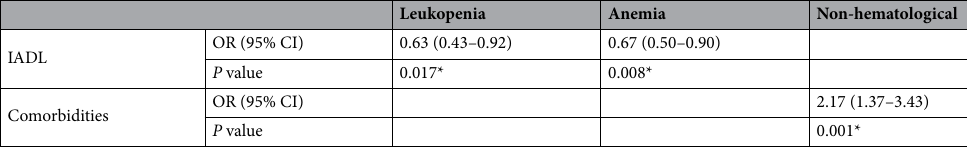
Table 6. Multivariate analyses of the relationship between CGA and toxicities (grade 3–4). CGA comprehensive geriatric assessment, CI confidence interval, IADL instrumental activity of daily living, OR odds ratio, *indicates significant difference; In multiple logistic regression analysis, raw scores of CGAs without binarization were used as covariates because of quasi-complete separation. Toxicities were analyzed using a